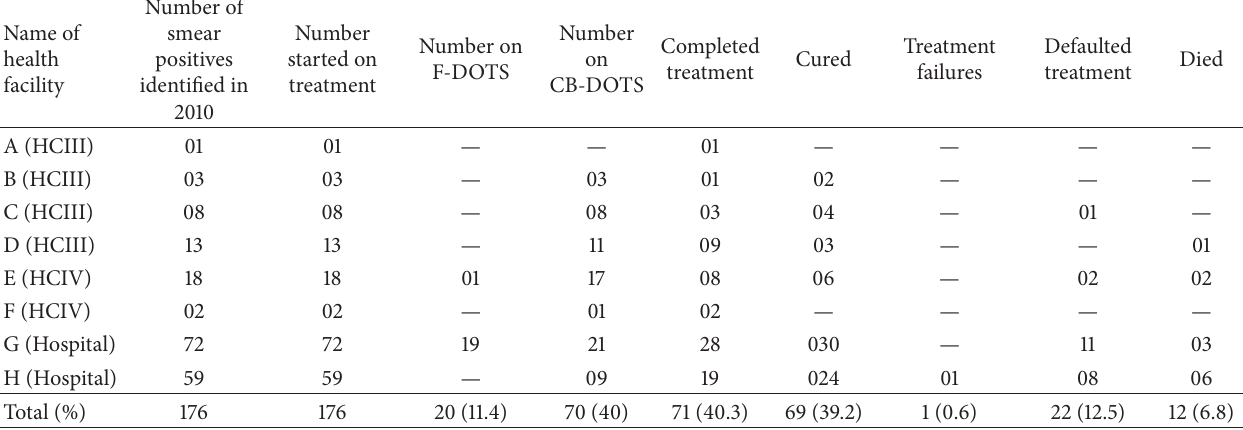
Table 6: Outcomes of TB service care for new sputum smear positive cases in Kamuli district health facilities for the year 2010. Name of